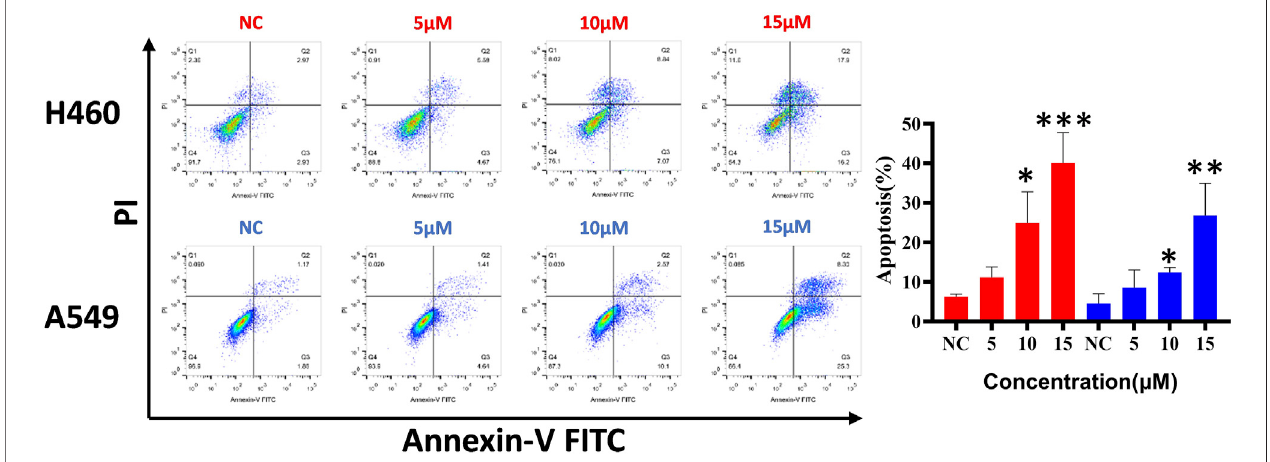
FIGURE 4 | Compound d17 induced apoptosis of H460 and A549. Flow cytometry analysis data from three independent experiments were summarized and shown. NC, negative control. * p -value < 0.05, ** p -value < 0.01, and *** p -value < 0.001 (one-way ANOVA, followed by Tukey ’ s